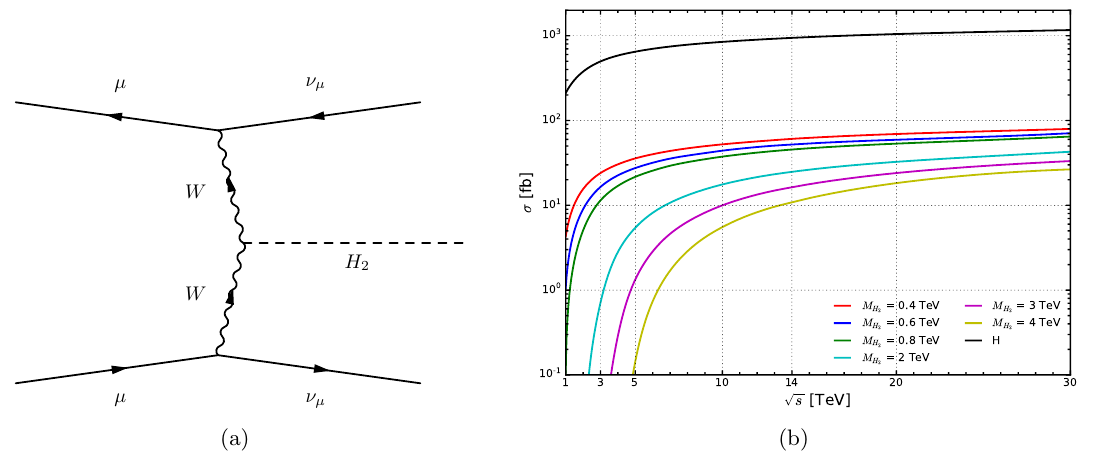
Figure 10 . (a) Diagrammatic representation of H 2 production through W + W (cid:0) fusion in the CP conserving 2HDM. (b) H 2 production cross section [fb] via VBF in (cid:22) + (cid:22) (cid:0) collisions as a function p of collider energy s [TeV] for representative H 2 mass ( M H 2